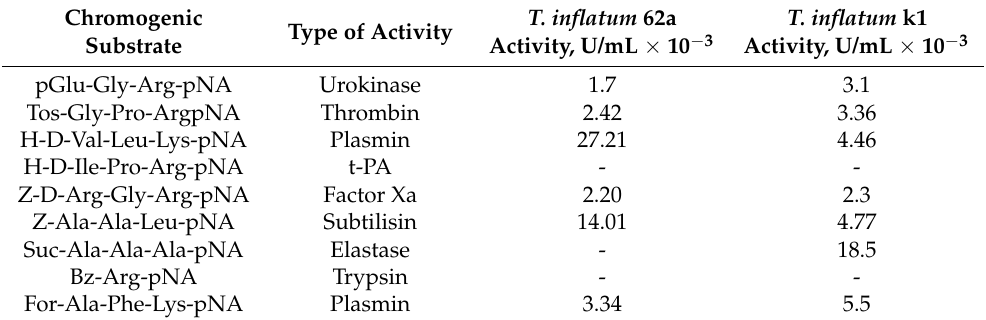
Table 4. Determination of proteolytic activity toward particular proteins of the hemostasis